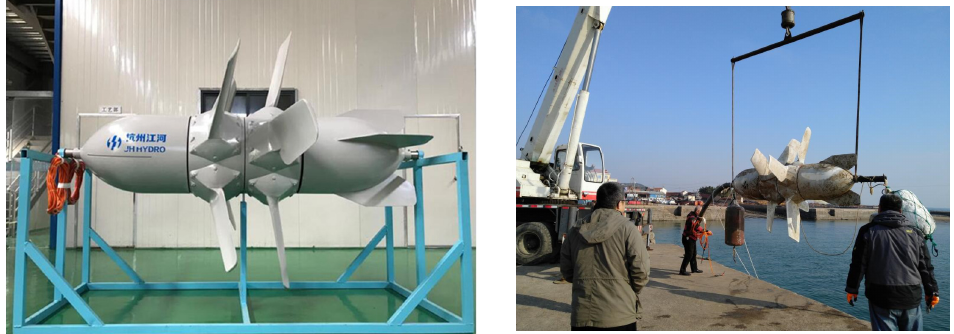
Figure 15. The power supply device for underwater marine instruments. Reproduced from [40,41].